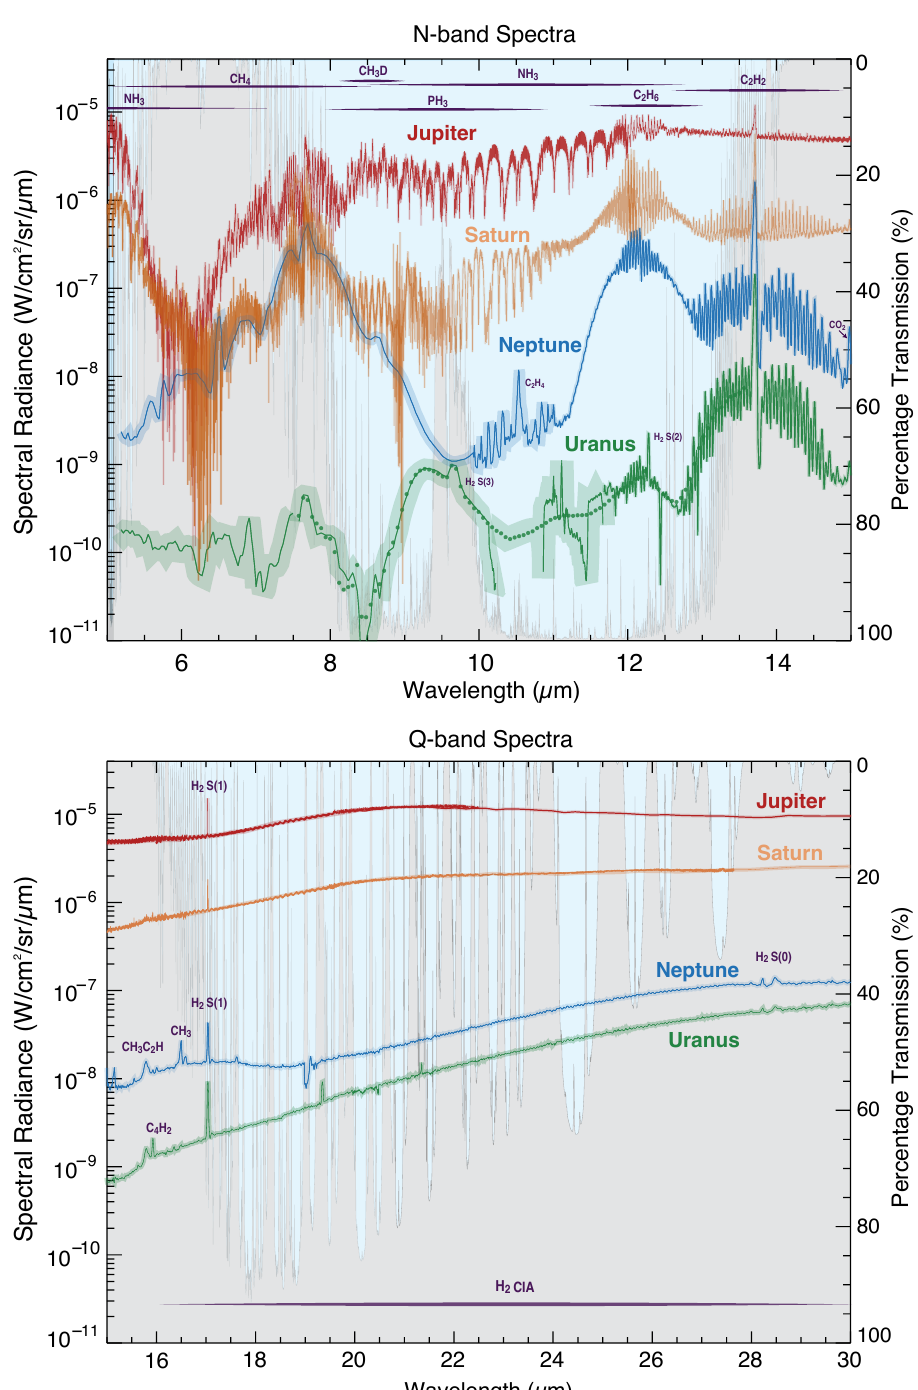
Figure 9. Observed mid-infrared spectra of giant planets in the N- and Q-bands (top and bottom panels, respectively). The spectra of Jupiter (red) and Saturn (orange) are from ISO-SWS [266] and Cassini-CIRS [141,237], while Uranus (green) and Neptune (blue) are disk-averaged radiances from Spitzer-IRS [74,76,275,276]. The rough uncertainty of the spectra (most evident for Uranus) is suggested by the faint transparent envelopes. Select emission features are indicated, and the wavelengths at which different gases broadly contribute to spectra are indicated by the labeled horizontal lines (purple). The atmospheric transmission is indicated by the blue–gray interface varying between 100% (full transmission) and 0% (total attenuation) from the top of the atmosphere down to a surface, as in Figure